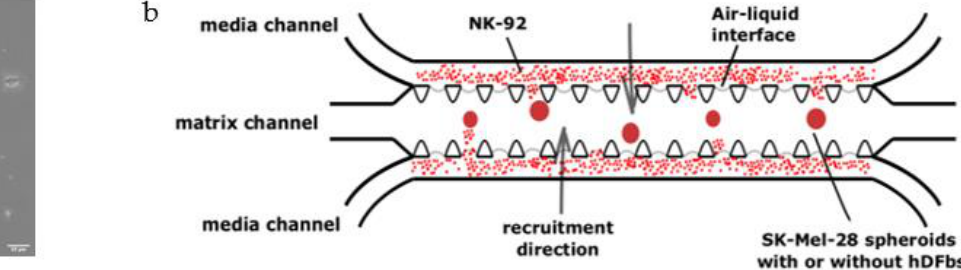
Figure 1. ( a ) SK-Mel-28 spheroids. Optic microscope. Magnification, 20×. Scale bar, 50 μ m. ( b ) Assay setup: SK-Mel-28 preformed spheroids (in monoculture or co-culture with hDFbs) were resuspended in a collagen matrix and added into the central channel of the microfluidic chip (AIM Biotech), which had the following dimensions: length of the channel, 10.5 mm; width of the gel channel, 1.3 mm; width of the media channel, 0.5 mm; gap between posts, 0.1 mm; height of the channel, 0.25 mm. In both lateral channels, NK-92 cells labeled with a fluorescent cell tracker were resuspended in MEM medium and were added at the final concentration of 2 × 10 6 cells/mL.